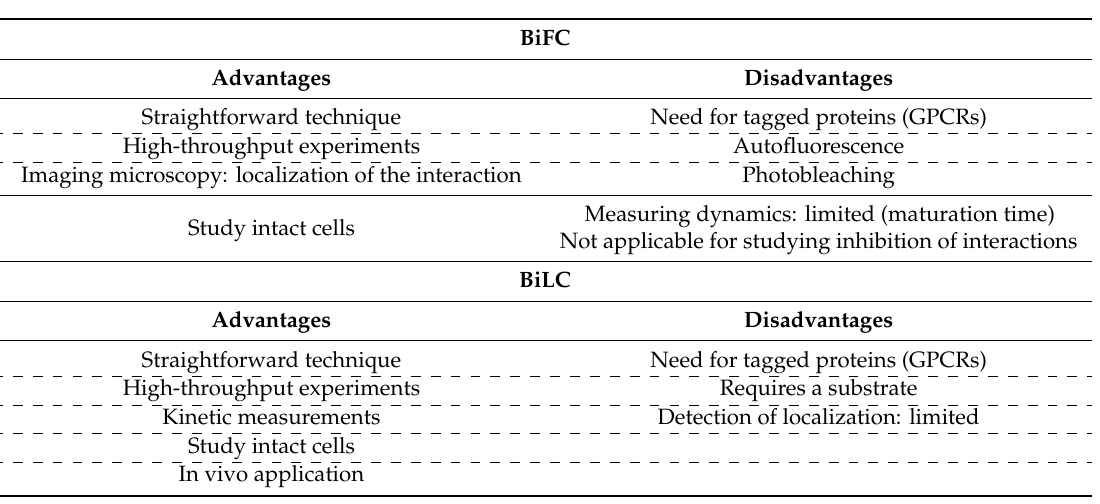
Table 3. Advantages and disadvantages of BiFC and BiLC techniques.